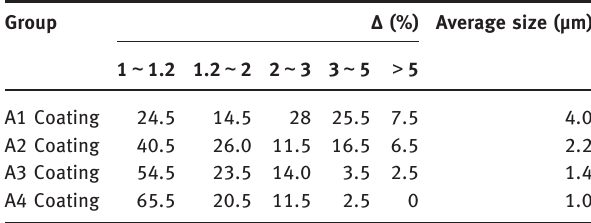
Table 7: Shape factor and size of TiC. Group